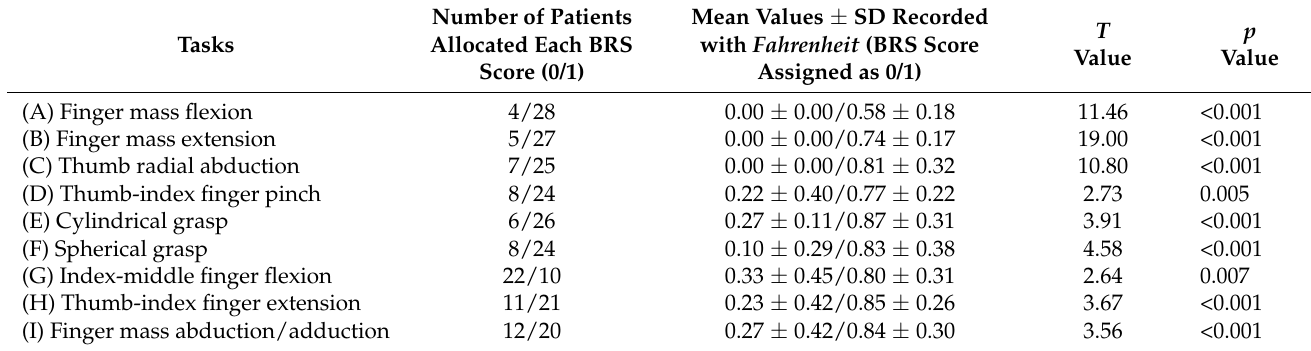
Table 2. The comparison of measurements in each task recorded with Fahrenheit .